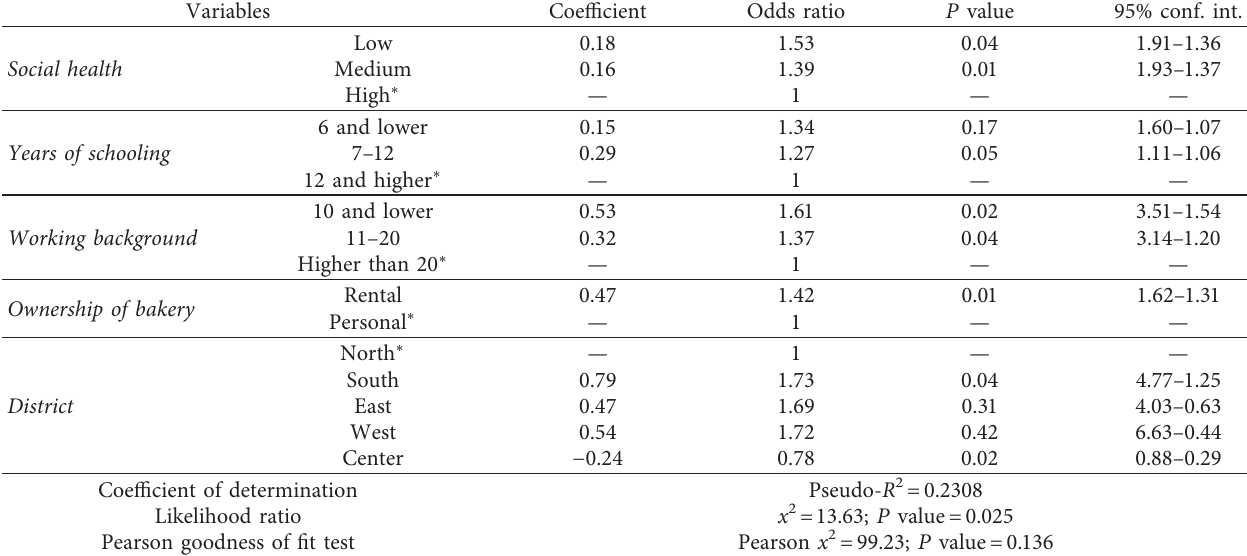
Table 3: Multivariate logistic regression between low bread quality and explanatory